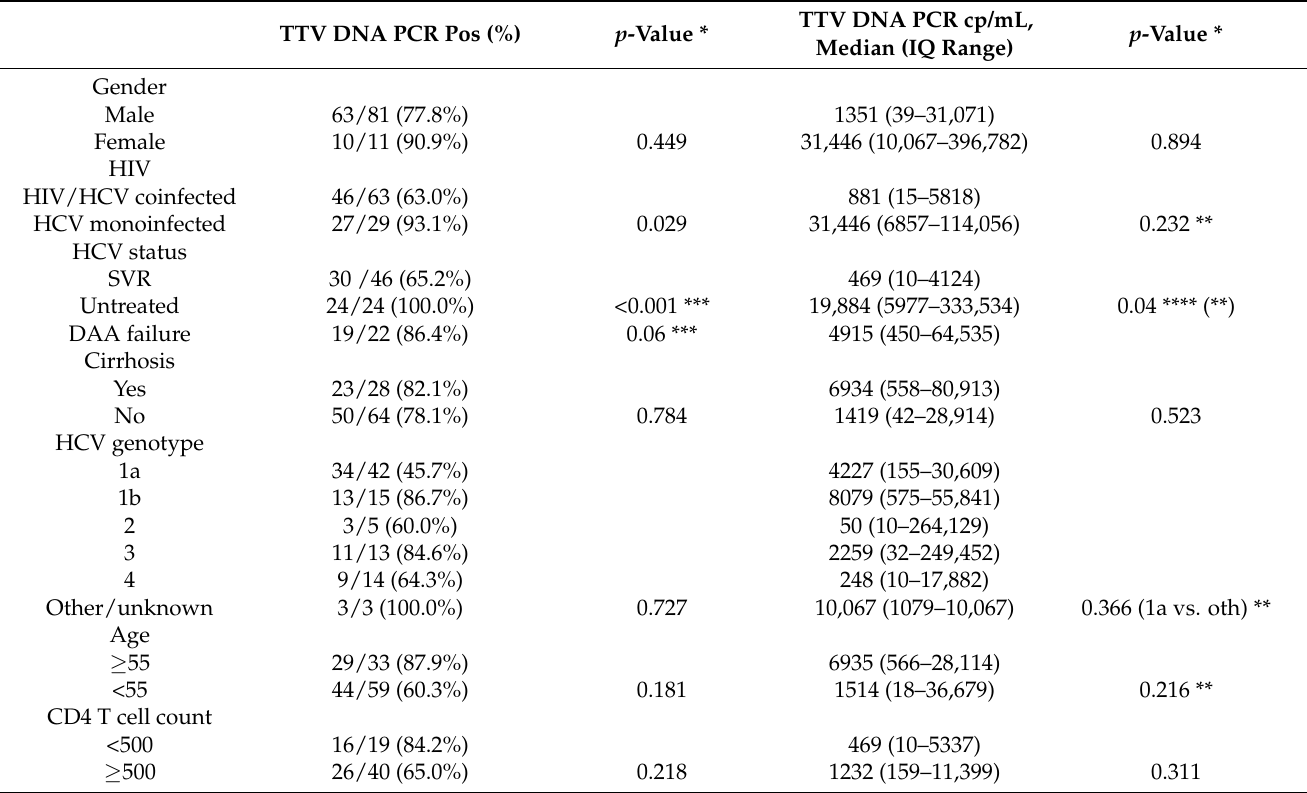
Table 2. Univariable association of TTV DNA positivity and copies/mL with viral markers.